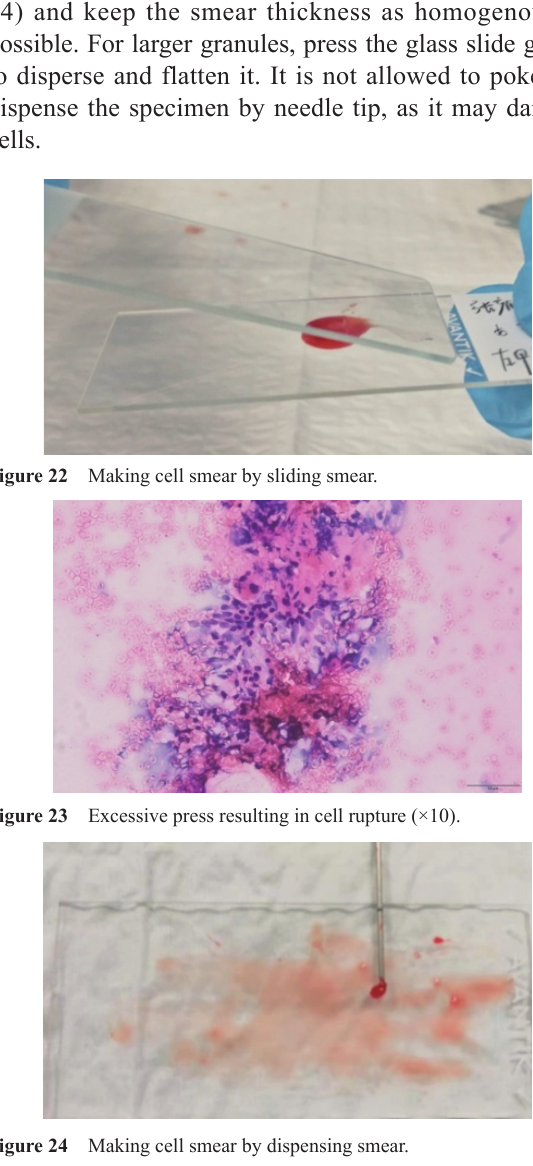
Figure 24 Making cell smear by dispensing smear.